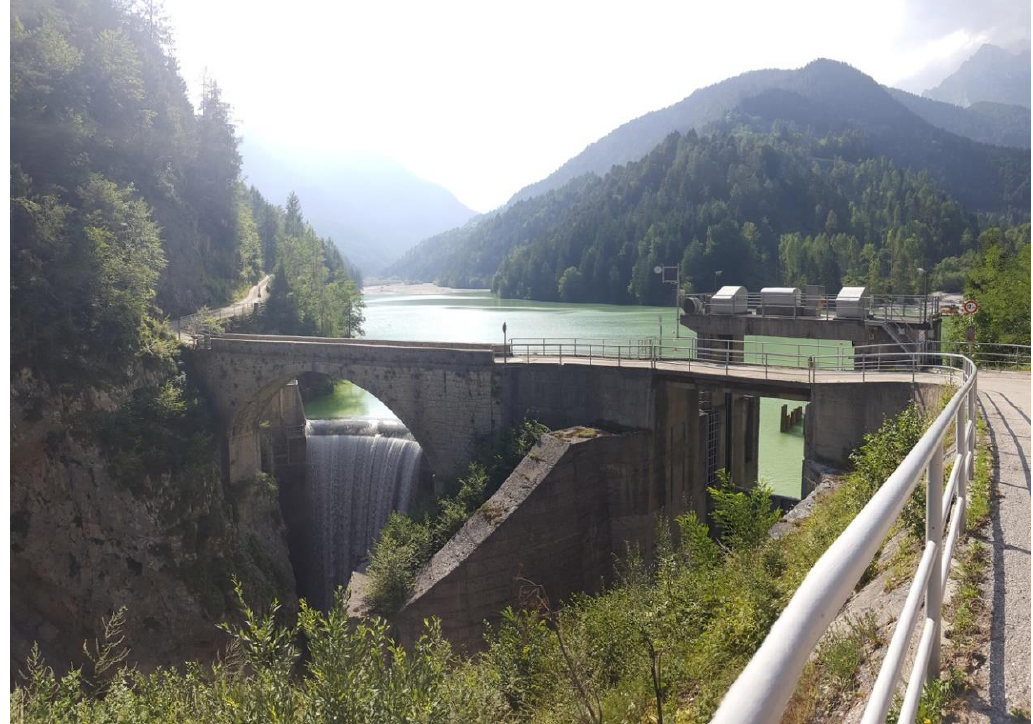
Figure 7. Valle di Cadore Dam—Italy (photo taken by the author on 11 August 2019).